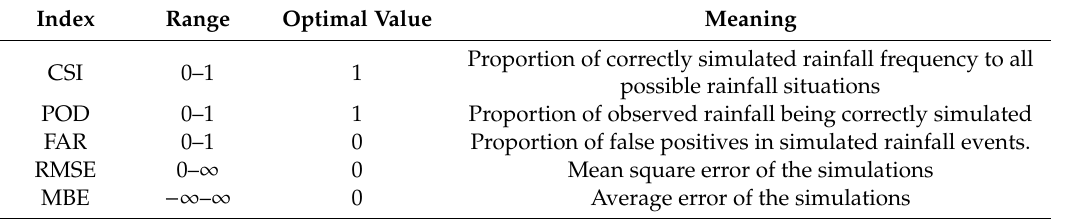
Table 4. Descriptions and ranges of the five indices for the rainfall spatial and temporal distribution.